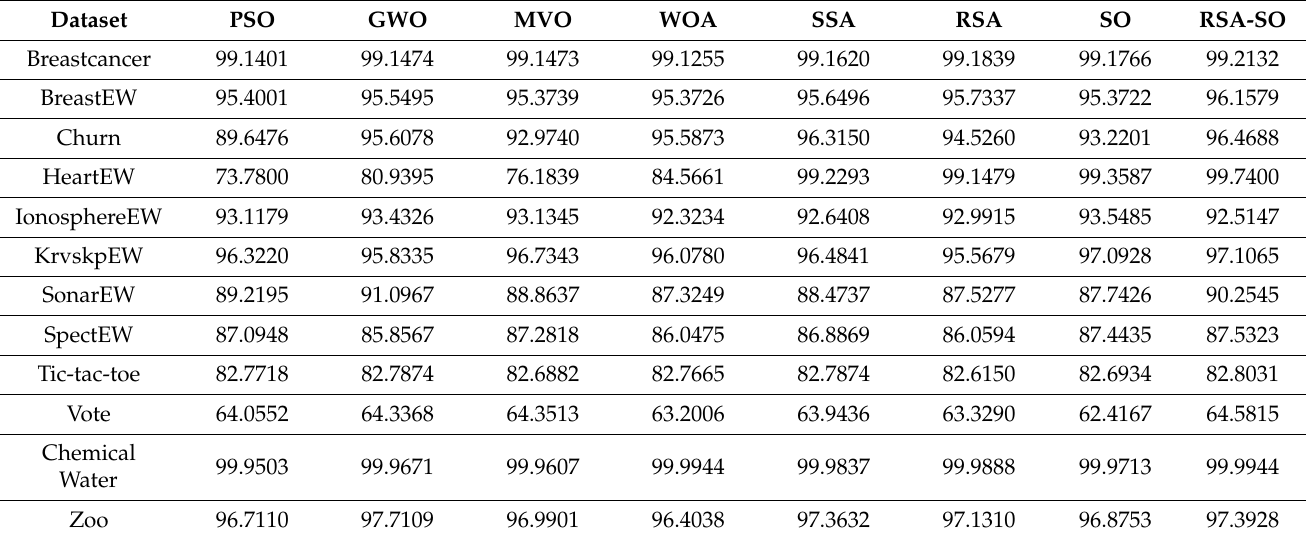
Table 3. Results of RSA-SO and other methods in terms of classification accuracy.